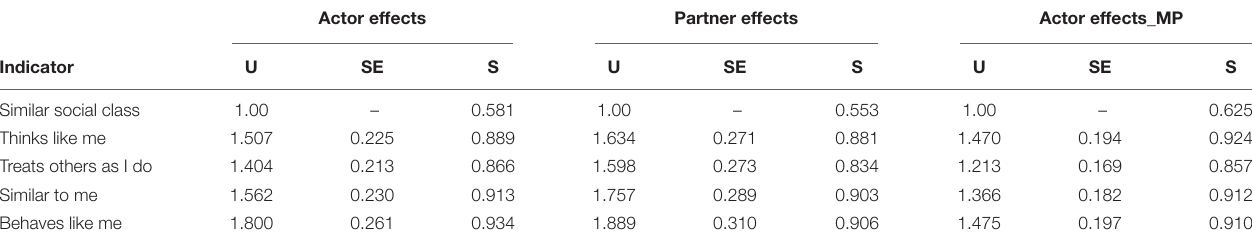
TABLE 3 | Measurement models individual level ARRMA interpersonal similarity construct in families.